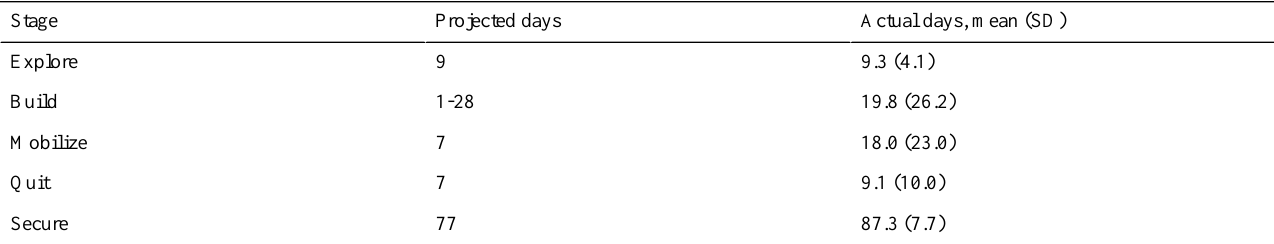
Table 4. Projected and actual days spent in each Pivot stage.